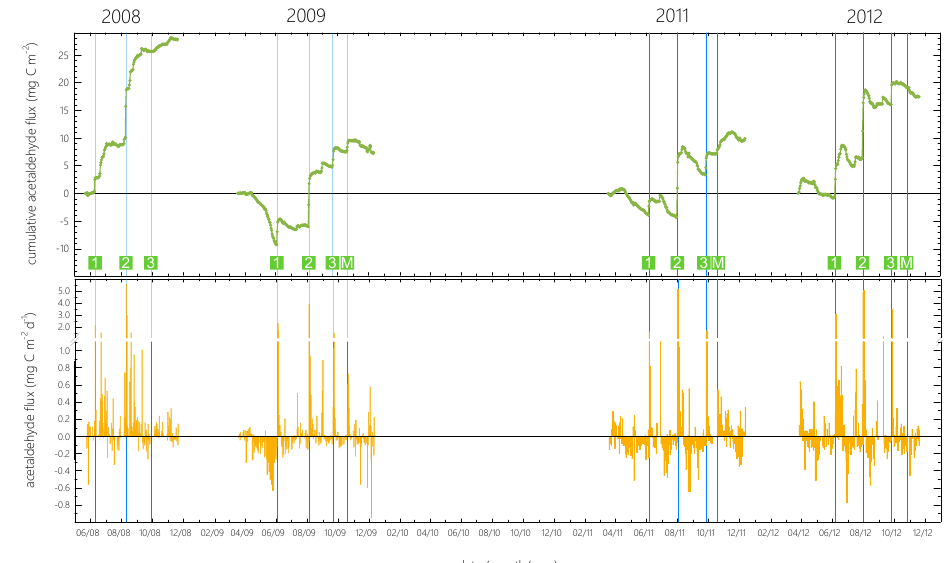
Figure 3. Cumulative and daily average acetaldehyde fluxes over 4 years of VOC measurements. Vertical lines show management dates, numbers 1, 2 and 3 in green squares mark the first, second and third cutting of the meadow, respectively, while M denotes manure spreading.